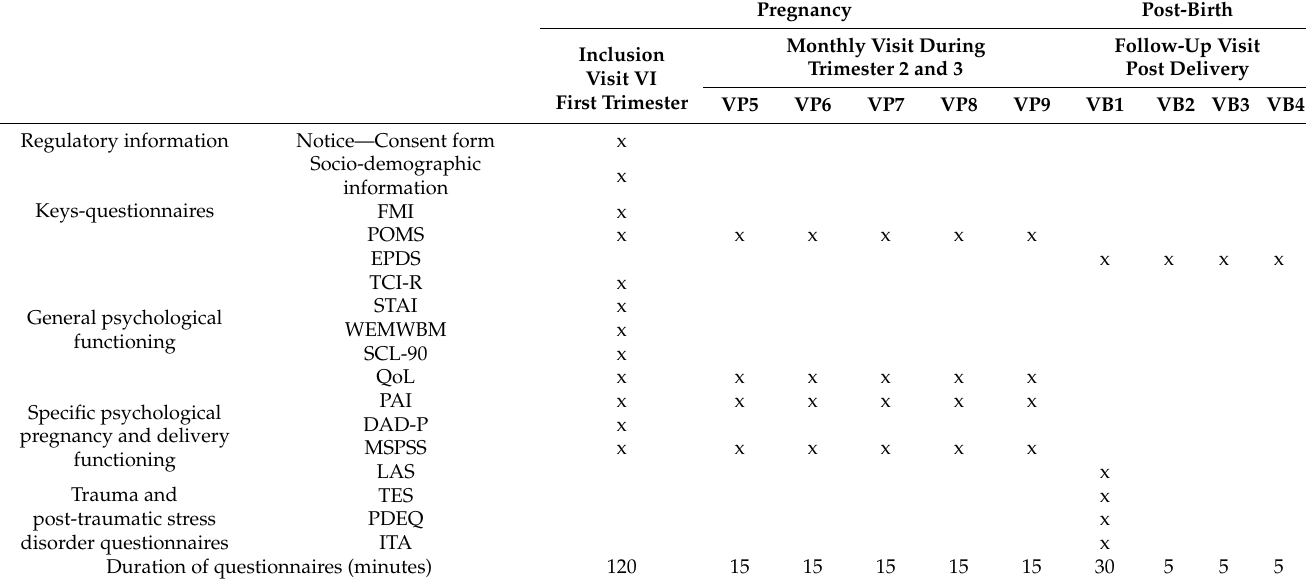
Table 2. Synopsis of study design. Details of visit requirements. Each participant will have to